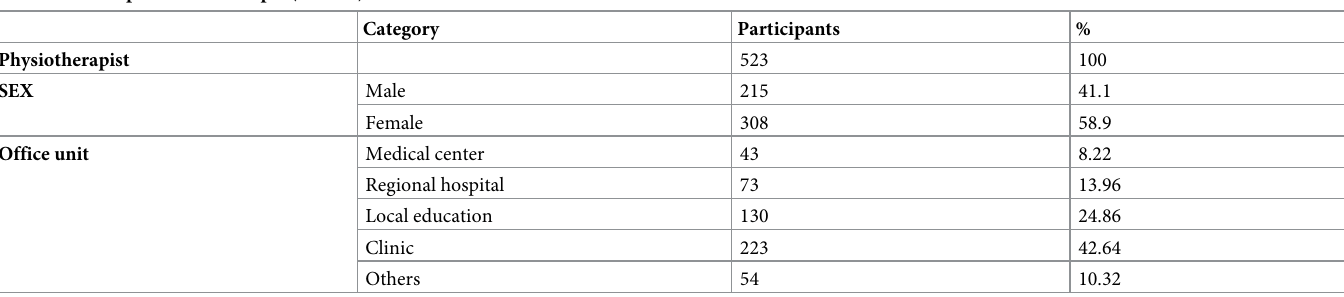
Table 2. Description of the sample (n = 523).